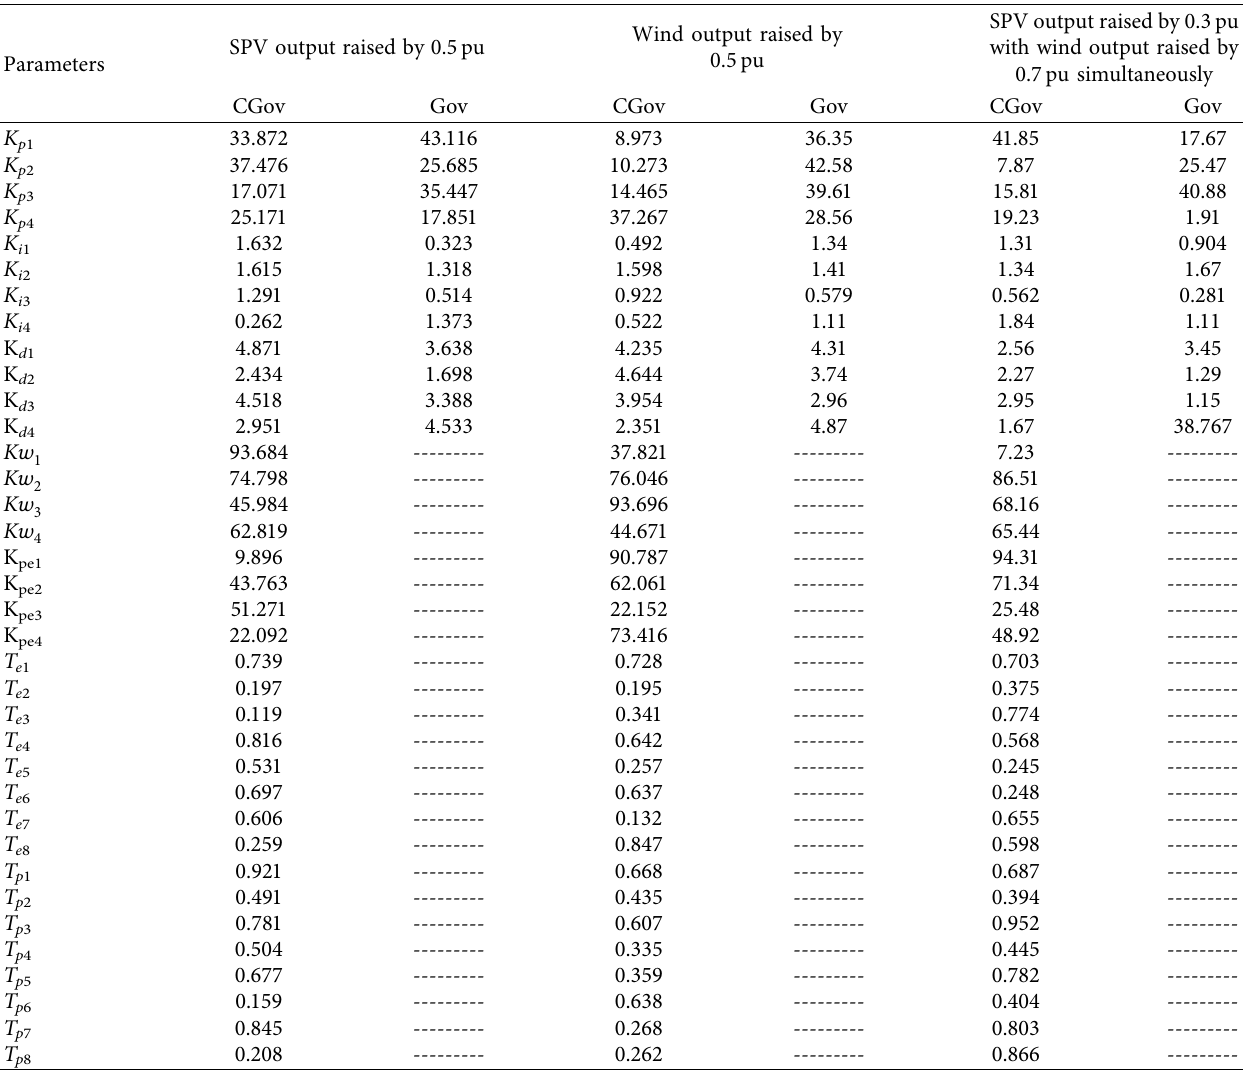
Table 4: Optimal parameters.